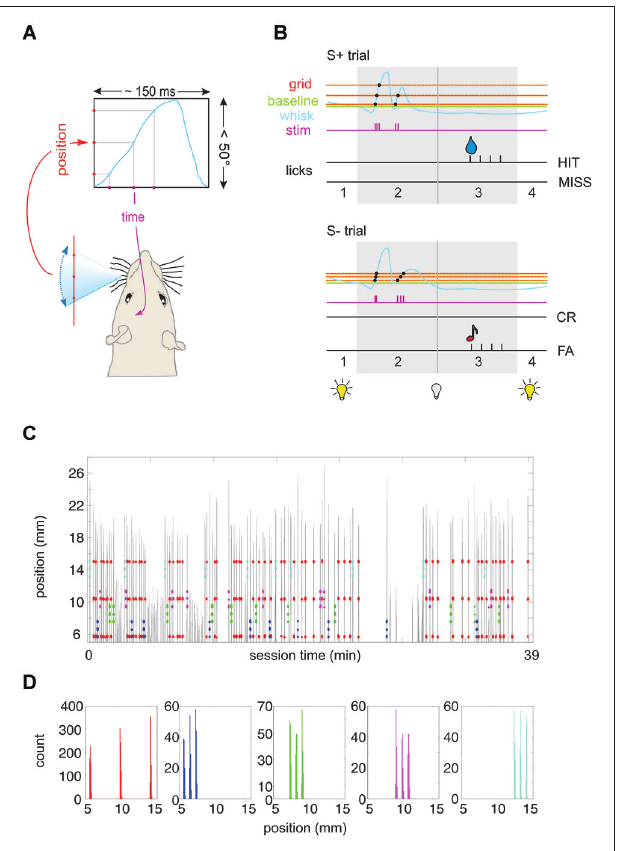
FIGURE 1 | Experimental paradigm . (A) Virtual grid. A real-time algorithm assessed the position of the whisker and generated an intracortical microstimulation (ICMS) pulse to the barrel cortex of the head-fixed rat whenever the whisker passed a pre-defined position. The blue curve depicts schematically one period of whisker movement. The virtual environment converts the spatial frequency of the grid (red) into the temporal frequency of the ICMS pulse train (purple). (B) Schematic of the behavioral paradigm. The house light was on as long as the whisker position was in front (protracted to) the base line (broken green line) (phase 1). Once the whisker retracted behind this line the house light went off to signal trial start. The rat had 1 s to sample the virtual grid (phase 2). Protraction movements (blue) across the grid (red) would activate single ICMS pulses (purple). After this period phase 3 allowed the rat to retrieve water reward (droplet) by licking from the spout in case of S + presentation (top). Depending on whether the rat licked the trial was classified as HIT or MISS trial. In case of S − presentation (bottom), a lick was counted as false alarm (FA) and followed by a tone. No lick was classified as correct rejection (CR). After the indicator interval (phase 3) the house light went on to indicate the end of the trial. (C) Spatial precision of virtual grid. Example session of rat 1 working on Test 3 (cf. Figure 3 ). Whisker movement across the laser optical device (LOD) is shown (gray; the distance of the LOD is 2 cm from the face, i.e., 1 mm ˆ= 2.86°). The position at which an electrical stimulation pulse was delivered to the barrel cortex is marked by colored dots (red: S + ; blue/green/magenta/cyan: S1 − /S2 − /S3 − /S4). (D) Same session as shown in (C) . Here the distribution of positions at which a stimulation pulse occurred is plotted for the five different stimuli (colors correspond to panel C ). The spatial spread of a virtual grid point measured in this way (across all stimulations in all rats) displays a standard deviation of 0.2 ◦